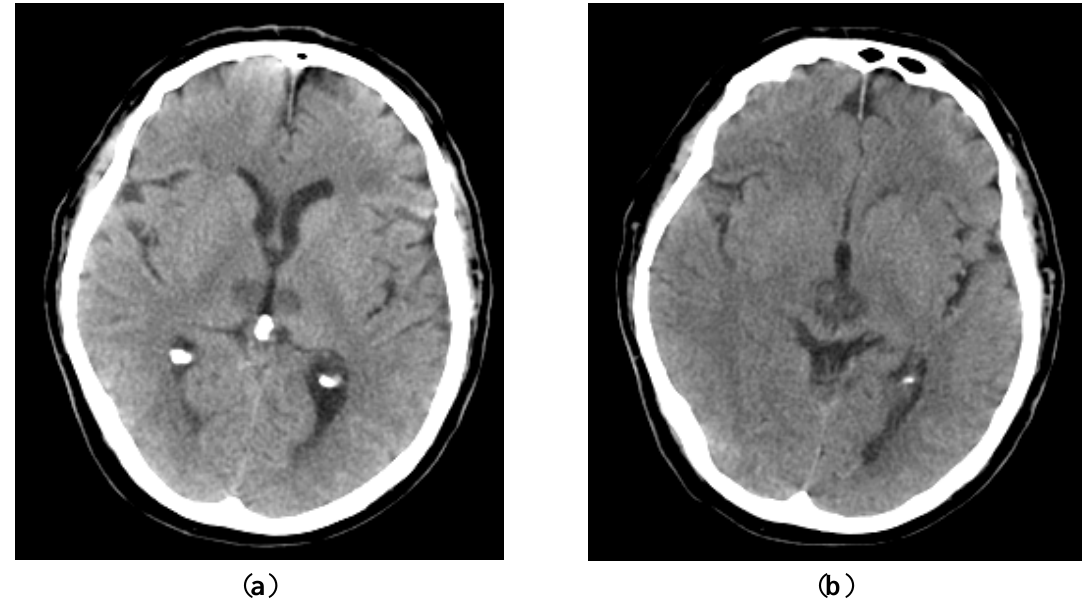
Figure 1. Bilateral thalamus and mid brain infarction involving Artery of Percheron. ( a ) Bilateral thalamic infarcts; ( b ) Bilateral midbrain